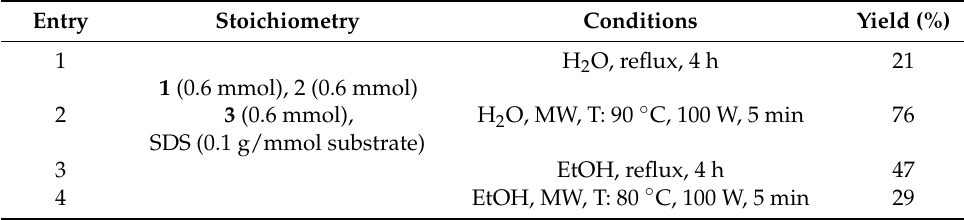
Table 1. Optimization of the reaction for the synthesis of 4 .